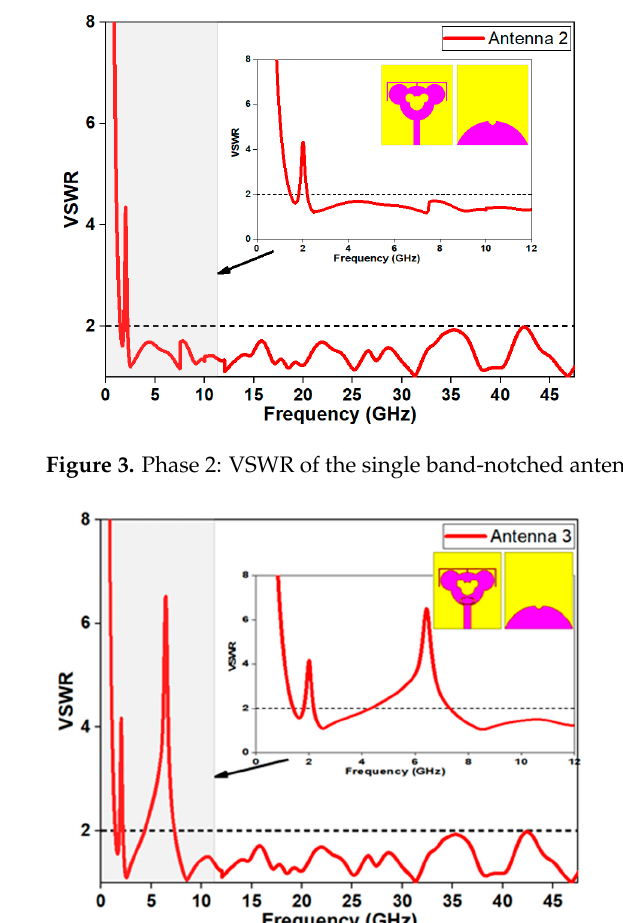
Figure 4. Phase 3: VSWR of the dual band-notched antenna.